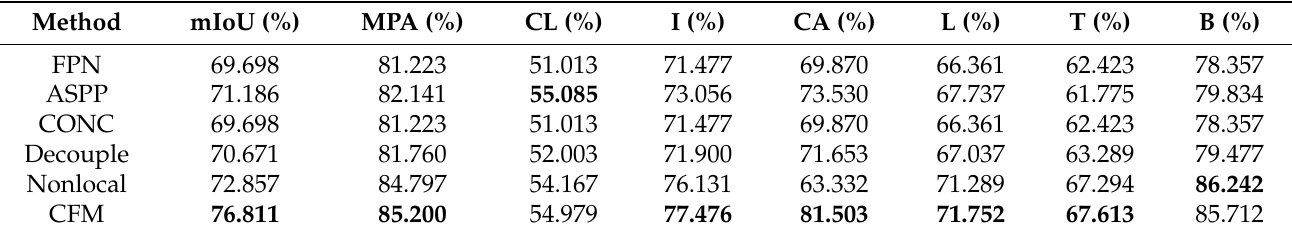
Table 5. Results of different fusion modules on Potsdam dataset. CL means clutter. I means impervious surface. CA means car. L means low vegetation. T means tree. B means building. The highest scores are marked in bold.